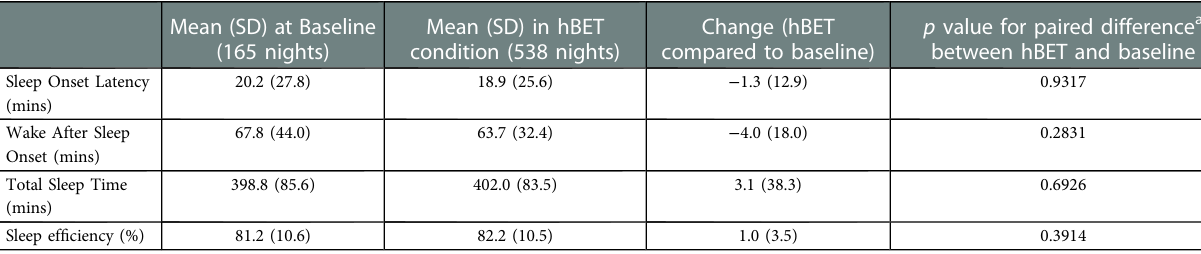
Change (hBET compared to baseline)